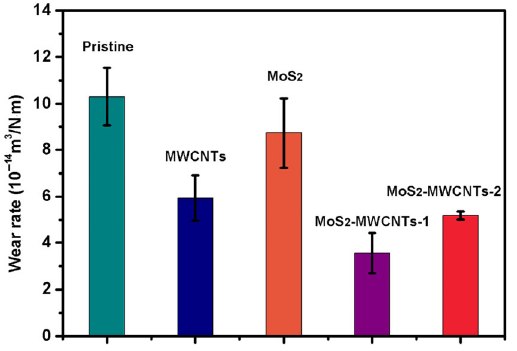
Fig. 7 Wear rates of the different filler reinforced polyurethane composite coatings.